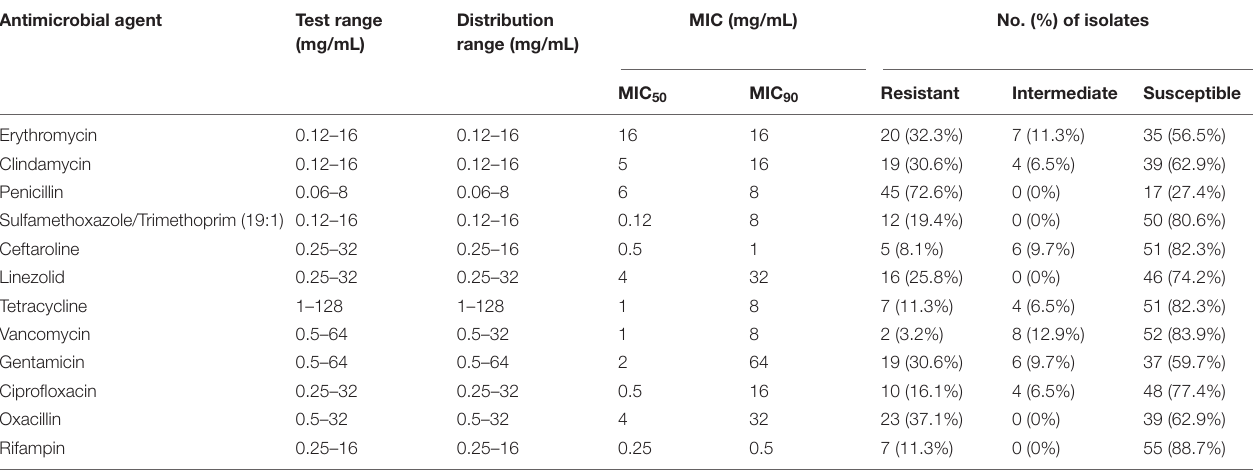
TABLE 4 | Antimicrobial susceptibility of S.